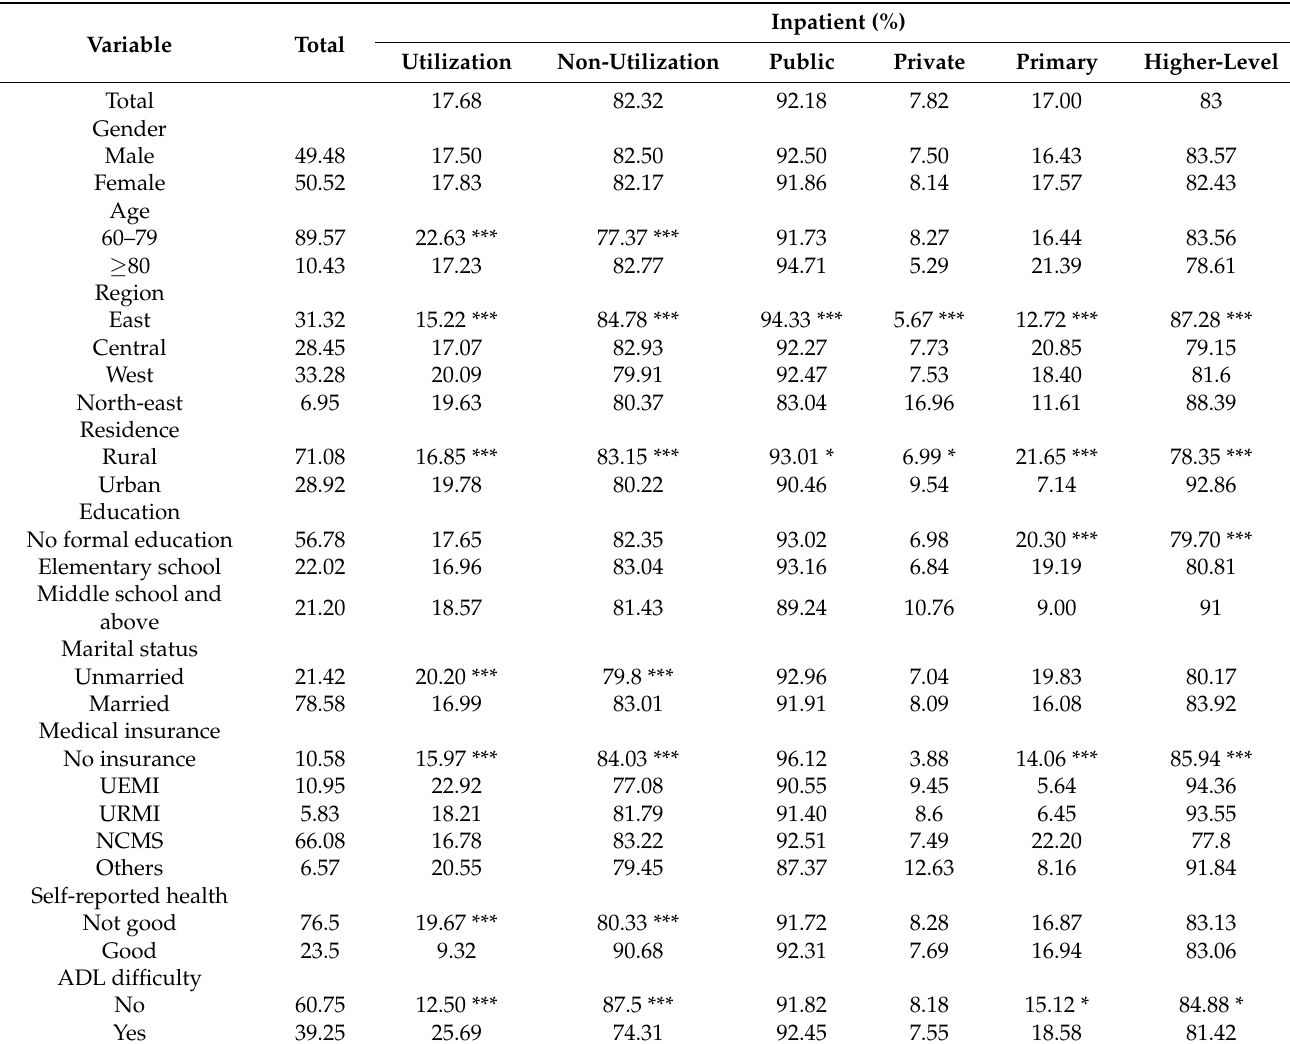
Table 2. Sample characteristics by inpatient healthcare utilization and the choices of inpatient healthcare providers ( N = 10,172).